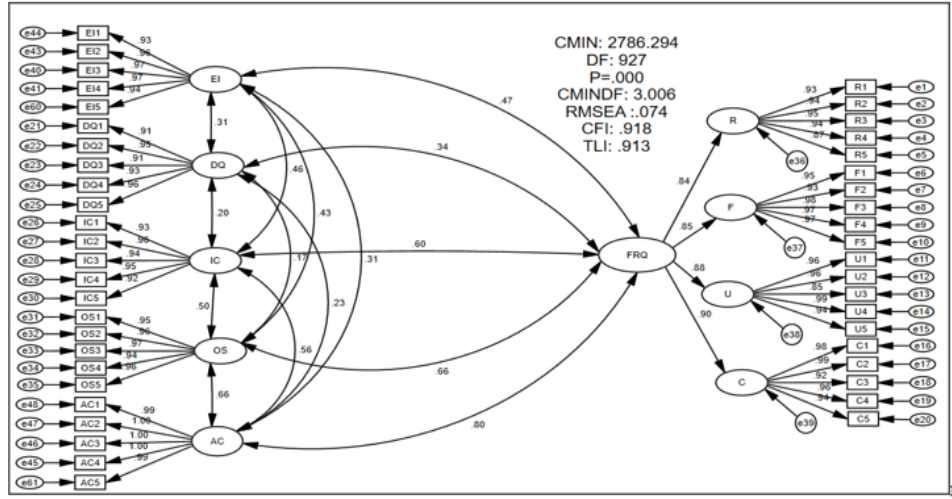
Figure 2. Assessment of measurement model.